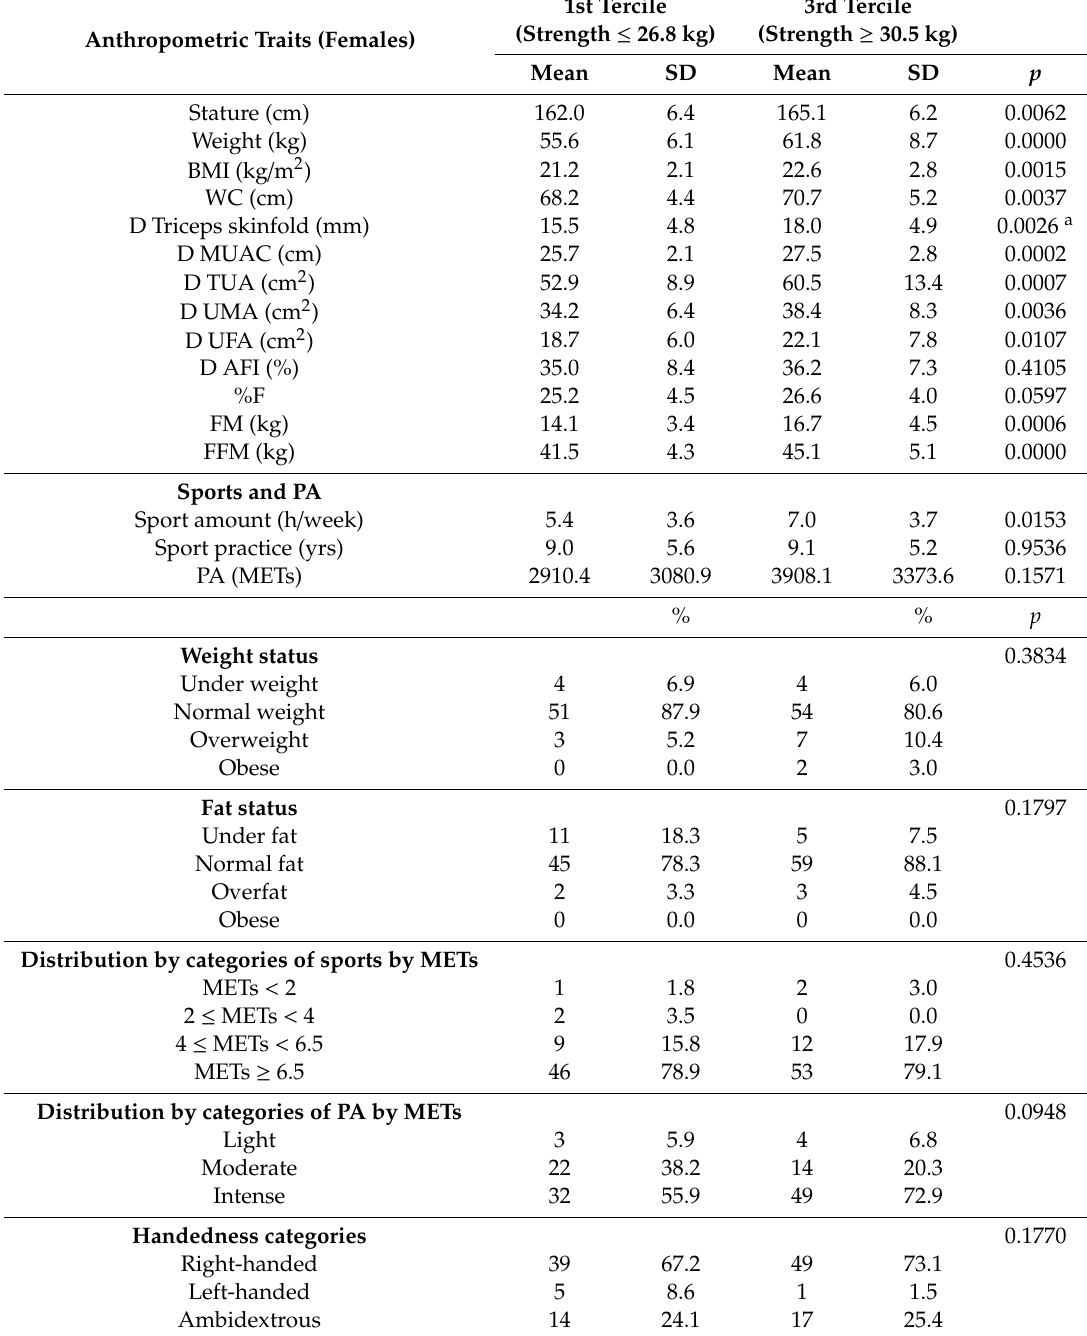
Table 5. Comparison between the lowest and the highest tercile of dominant handgrip strength in females (D = dominant